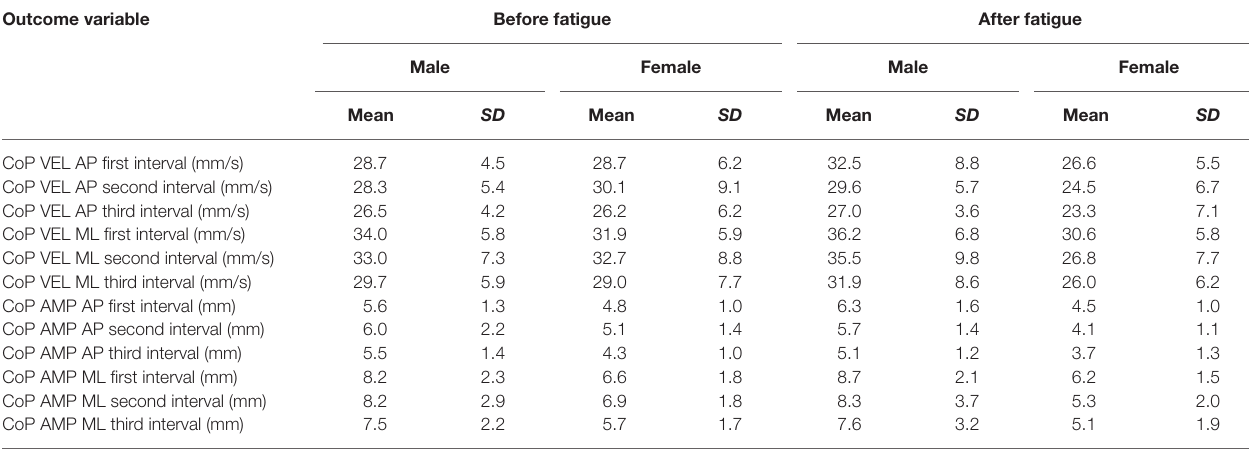
TABLE 2 | Interval-specific descriptive statistics. Outcome variable Before fatigue After